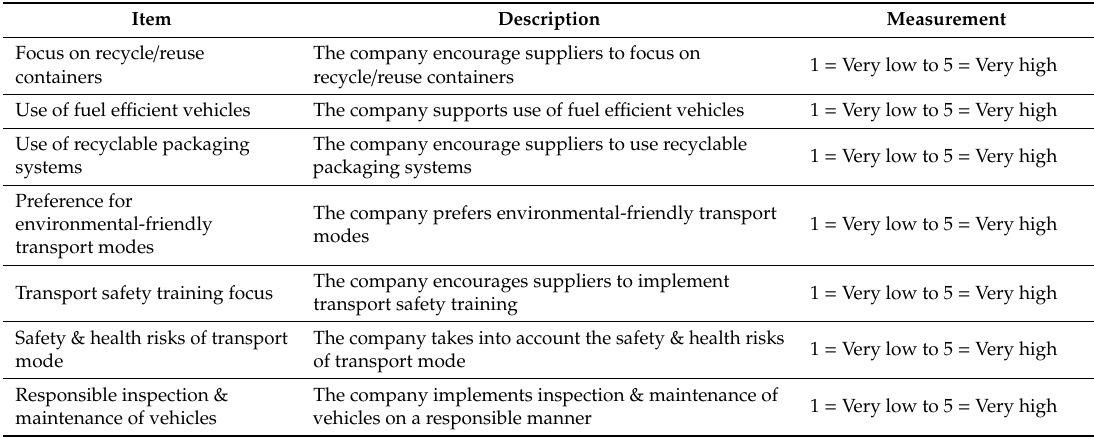
Table 3. Logistics Management strategy